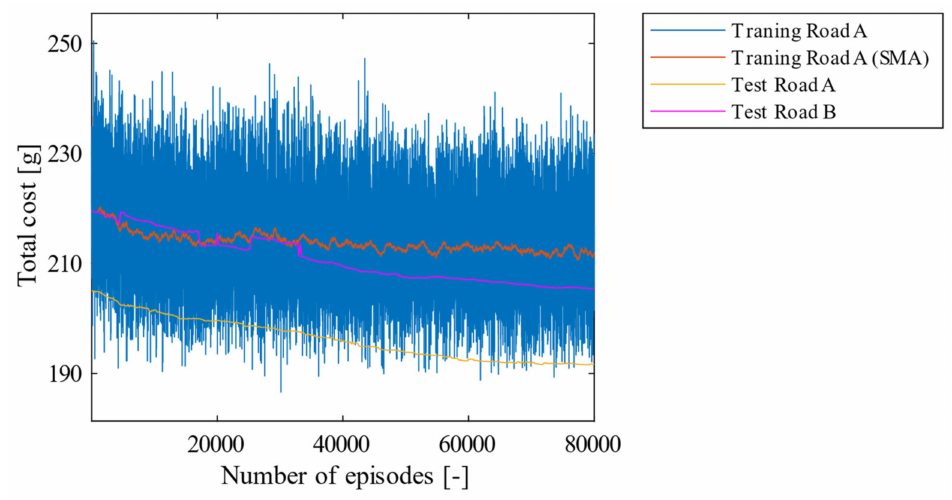
Figure 11. Total cost transition for each episode for the training/testing data by the proposed method without the traffic congestion vector. (SMA: Simple Moving